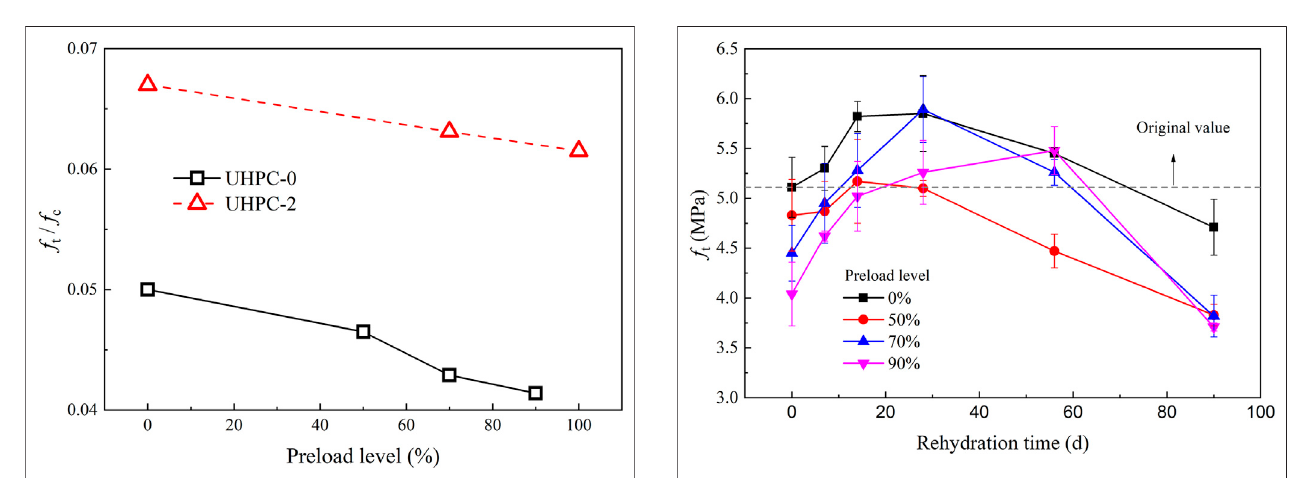
FIGURE 5 | Tension-to-compression ratio of specimens under different preload levels.